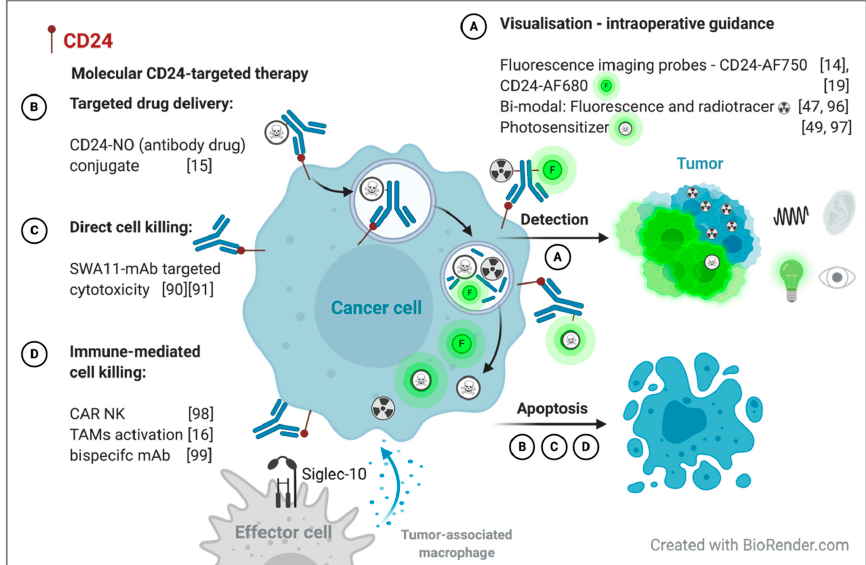
Figure 2. Potential of CD24 as a bimodal imaging biomarker for molecular CD24-targeted therapy ( A – C ) and radio- and fluorescent intraoperative guidance ( D ) with dual-labeled CD24 mAbs. A theranostic approach for personalized therapy. NO: nitric oxide, mAb: monoclonal antibody, CAR NK: chimeric antigen receptor-expressing natural killer cells, TAMs: tumor-associated macrophages, AF750: Alexa Fluor 750, AF680: Alexa Fluor 680